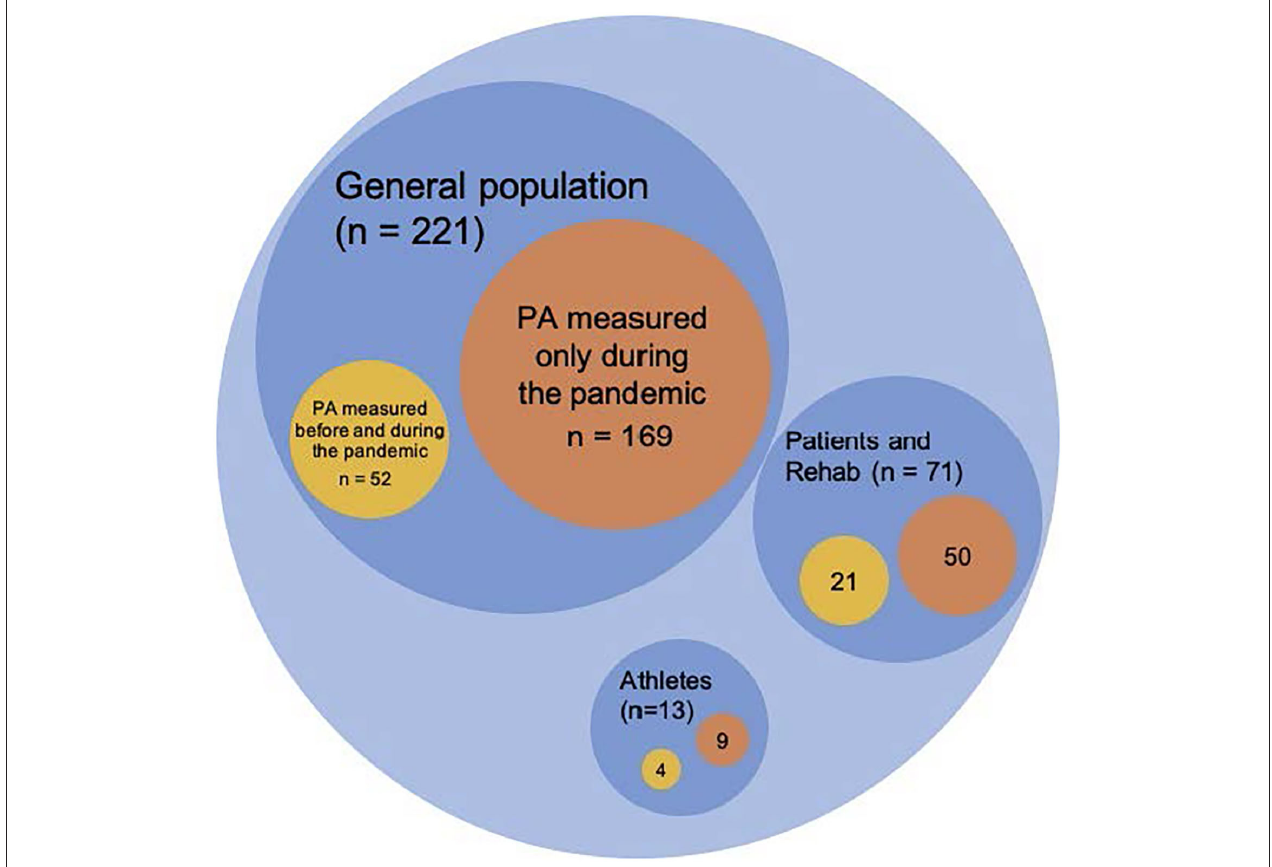
FIGURE 6 | Study designs and target groups. Number of empirical articles on PA behavior change in different populations and timing of data collection (graphical proportions are not exact for readability